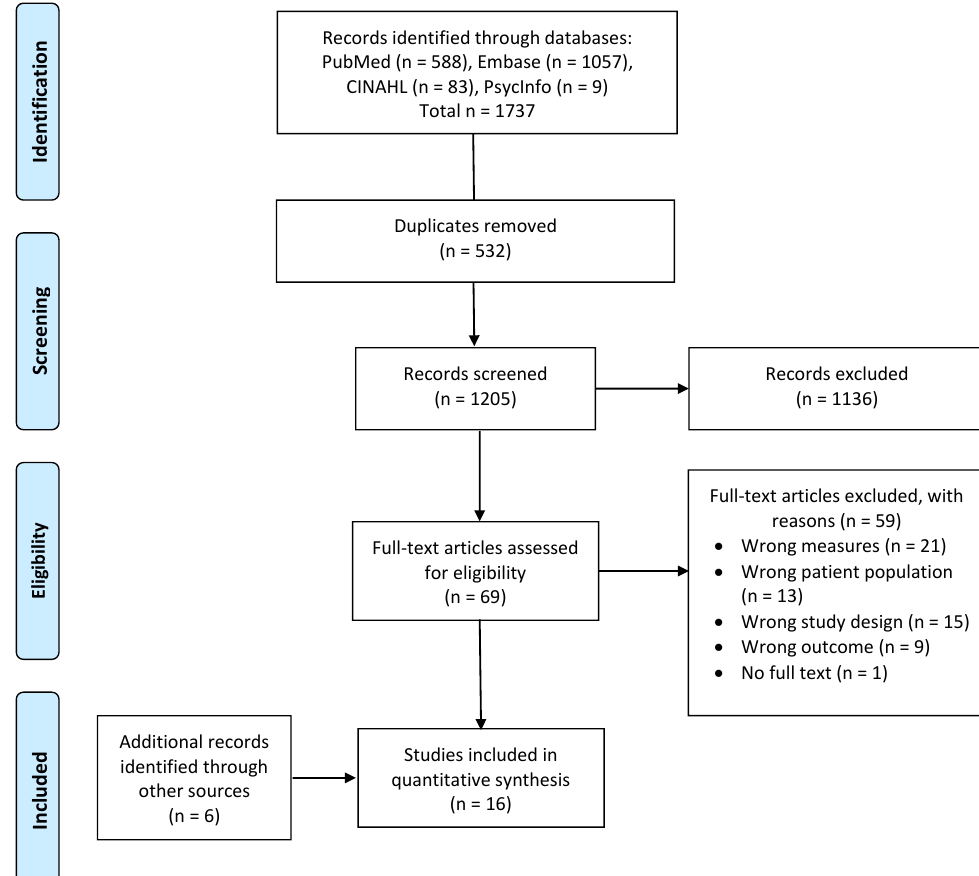
Figure 1. PRISMA flowchart.